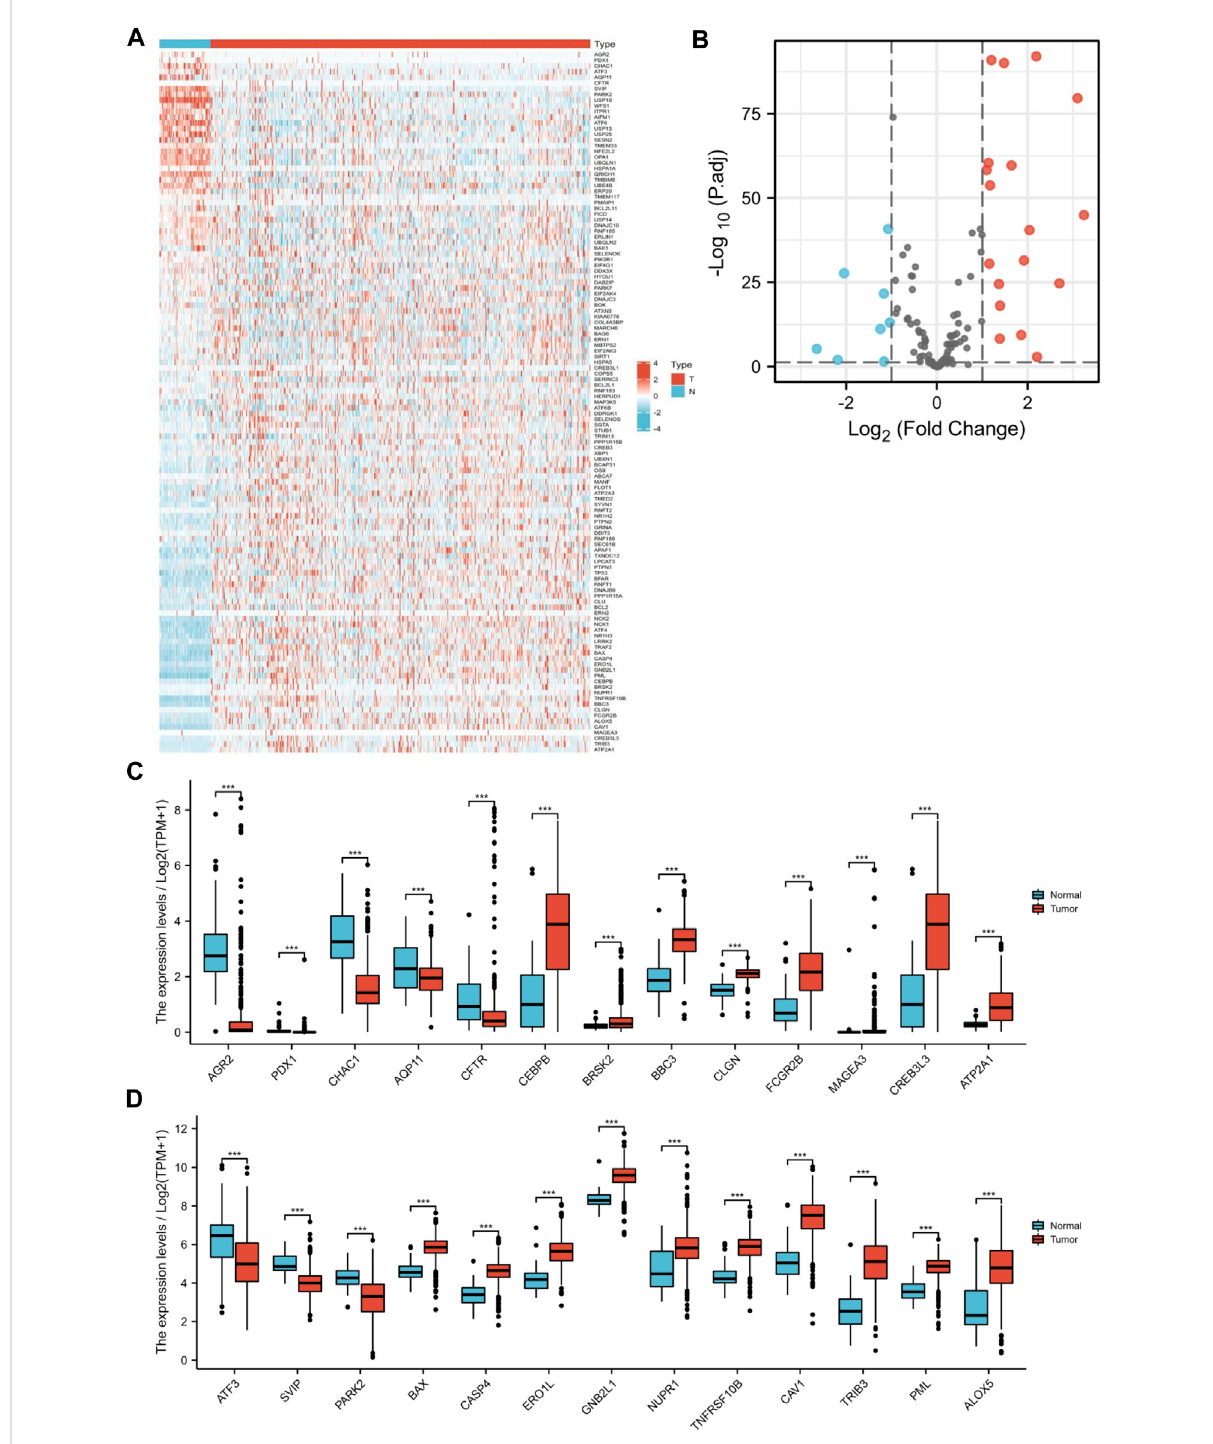
FIGURE 3 Distinction of ER stress-related DEGs in KIRC. ER stress-related DEGs were identi fi ed between KIRC and normal specimens in TCGA dataset with the cutoff values of |log 2 FC| > 1. (A) Heat map visualized upregulated and downregulated ER stress-related genes in tumor specimens (T) and normal specimens (N). Red means upregulated genes, and blue means downregulated genes. (B) Volcano map visualized upregulated and downregulated ER stress-related genes. Red means upregulated genes, blue means downregulated genes, and gray means nonsigni fi cant genes. (C,D) Expression of 26 ER stress-related genes between tumor specimens (T) and normal specimens (N) (*** p <